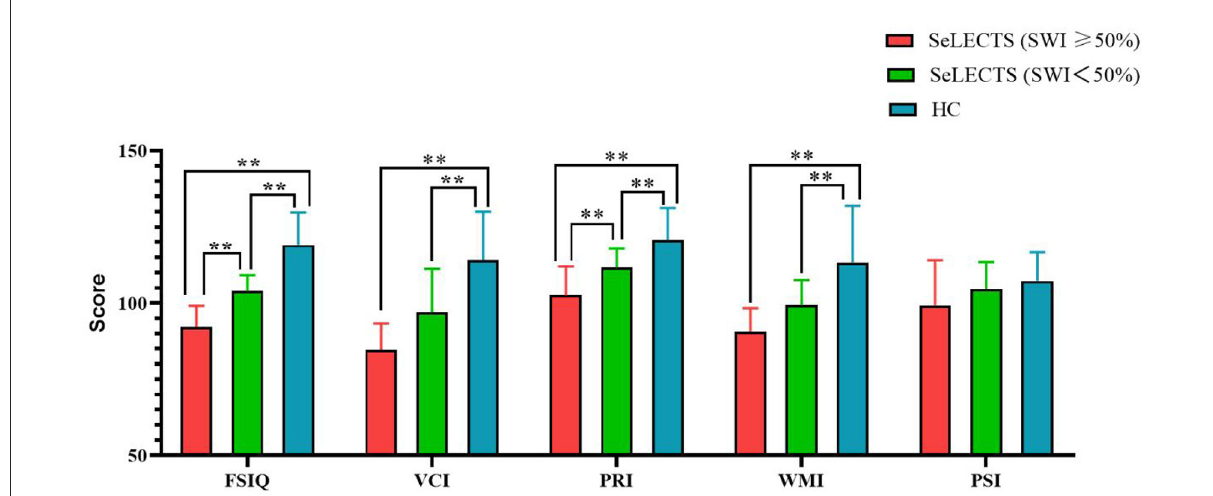
FIGURE1 Comparison of WISC-IV scores between the SeLECTS (SWI ≥ 50%), SeLECTS (SWI < 50%), and HC groups. FSIQ, Full-scale Intelligence Quotient; VCI, verbal comprehension index; PRI, perceptual reasoning index; WMI, working memory index; PSI, processing speed index. **, The p -value was statistically significant.